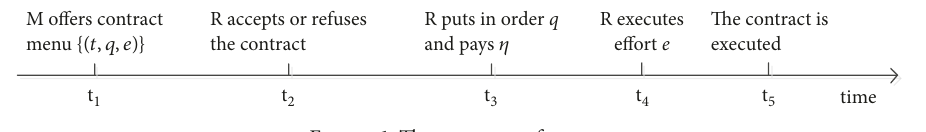
Figure 1: The sequence of